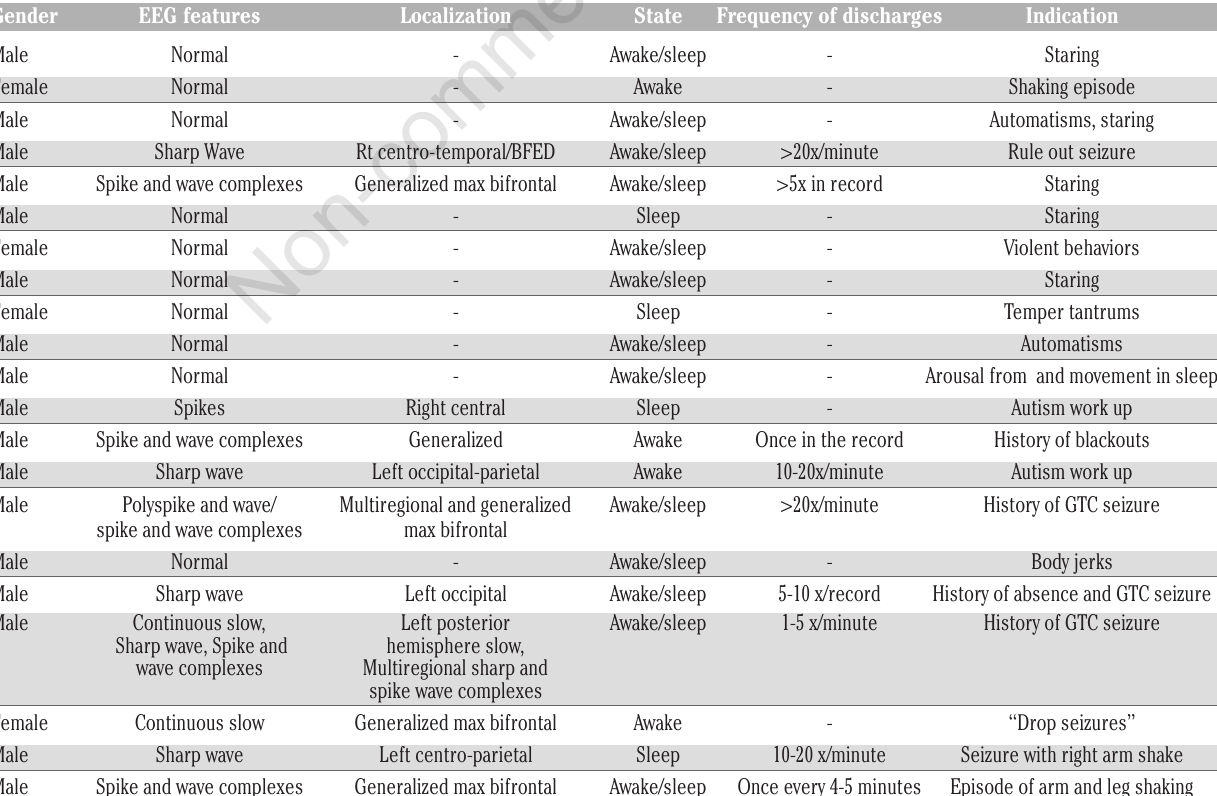
Table 2. Description and indications of EEG performed in children with Autism Spectrum Disorder.